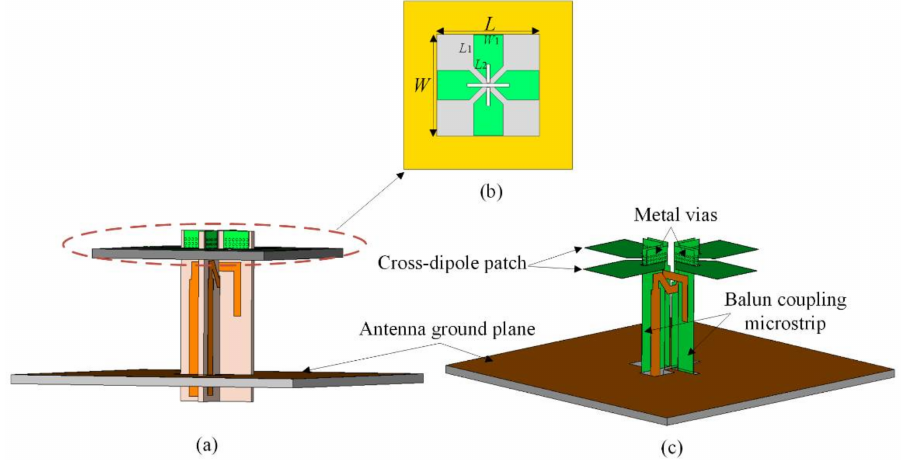
Figure 1. ( a ) Side view with dielectric substrate of matching balun and cross-dipole patches. ( b ) Top view of the cross-dipole patches. ( c ) Three-dimensional view without dielectric substrate of matching balun and cross-dipole